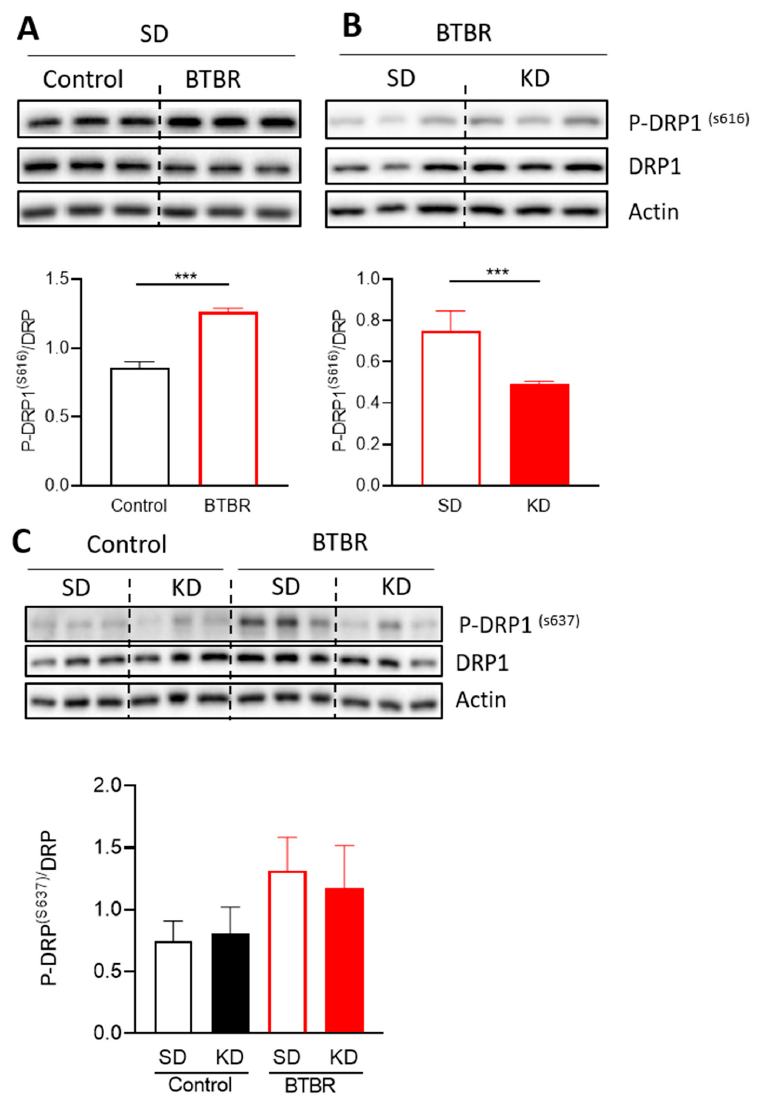
Figure 5. Changes in mitochondrial proteins responsible for mitochondrial fission and fusion due to the KD. Densitometry analysis and representative blots of P-DRP1 S616 , ( A ) comparing control and